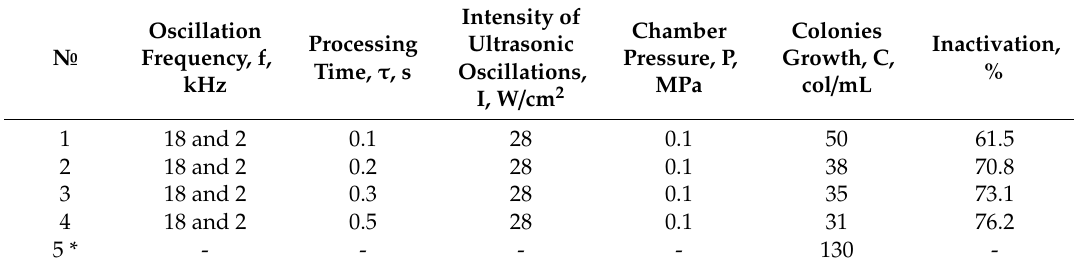
E ff ects of the combination of ultrasonic treatment and a hydrodynamic emitter on microorganism